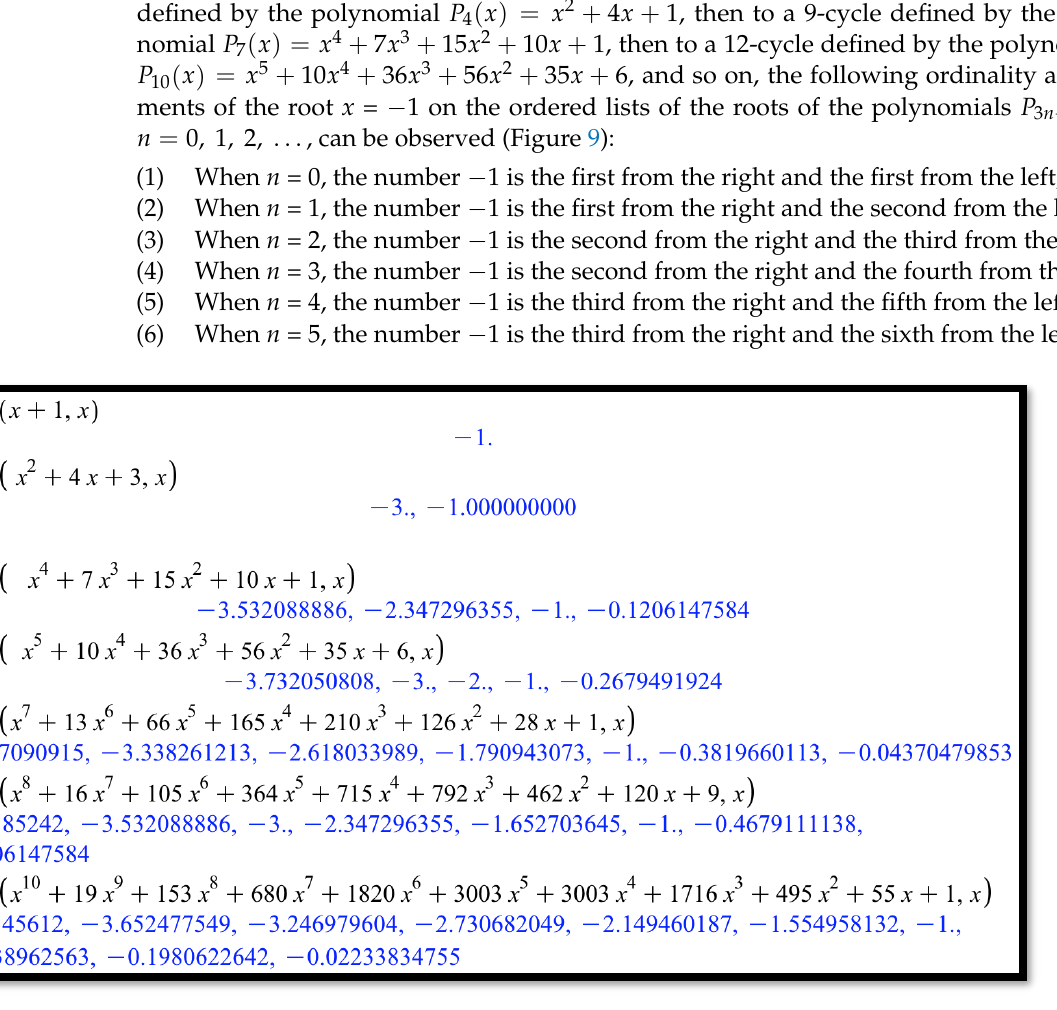
. Figure 10. Using Maple to determine OAs of the root of 𝑃 3 (𝑥).